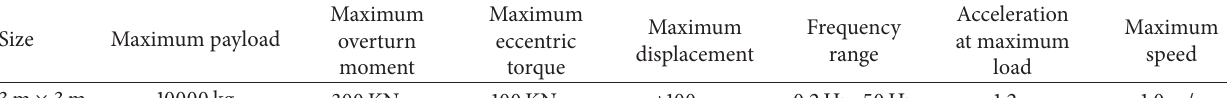
Table 1: The vibration table characters.